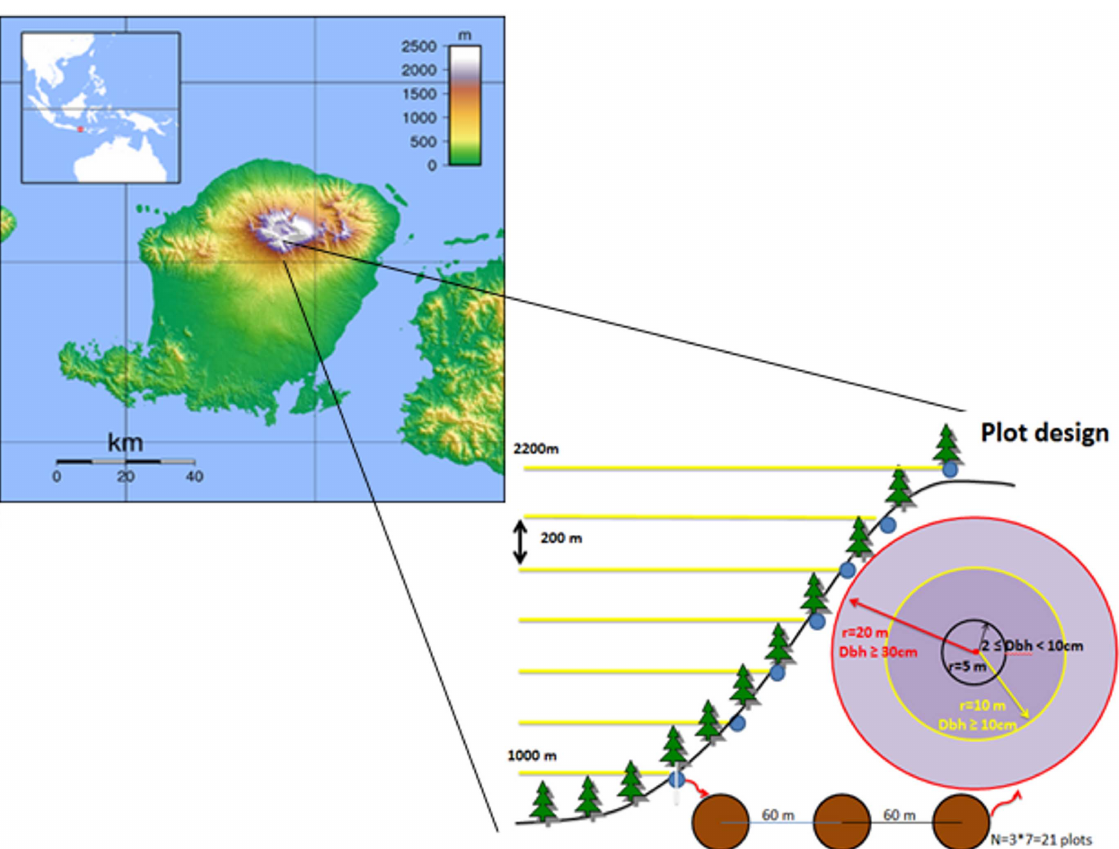
Figure 1. Map of the Island of Lombok and Mt. Rinjani, the study site, and the sample design. It was not possible to sample vegetation below 1000 m because of human disturbance and above 2000 m were fire-maintained grasslands. Access was only possible through using the main hiking trail on the north slope of the mountain.